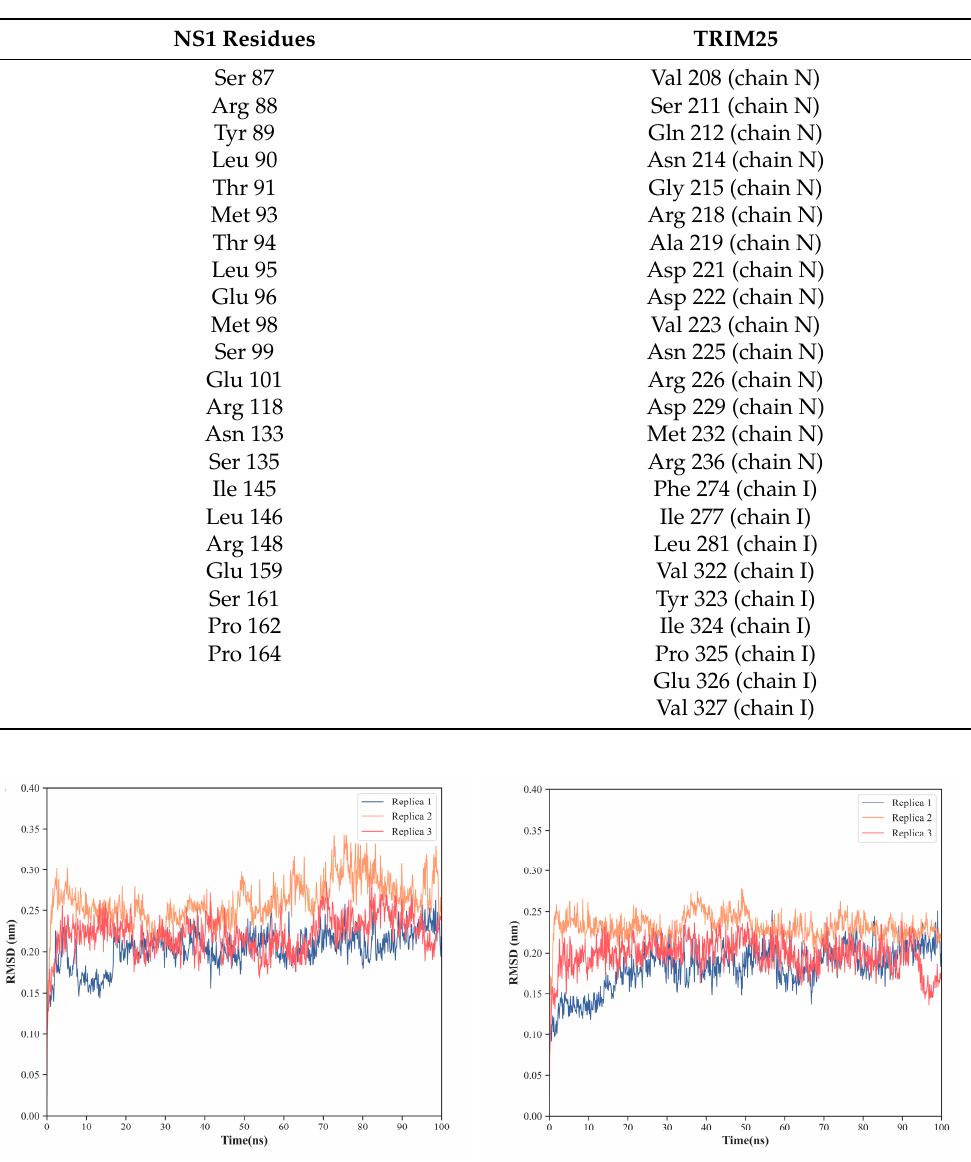
Table 2. Amino acid residues constituting the interfacial region in the NS1-TRIM25 complex.